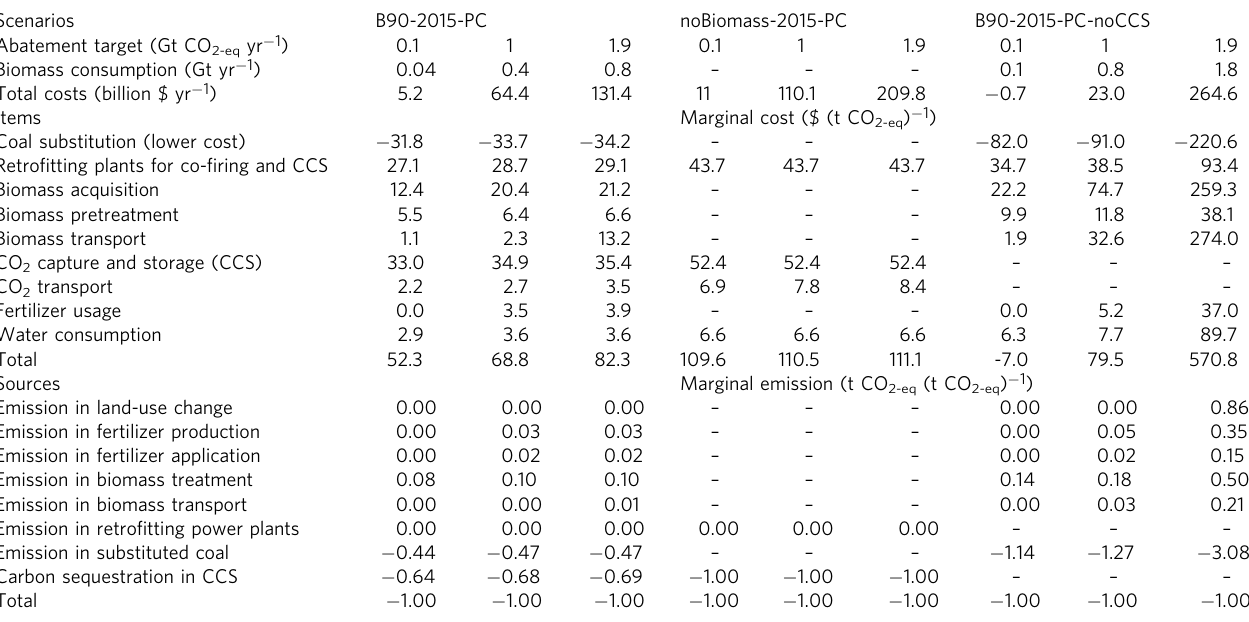
Table 1 Costs and CO 2 -equivalent emissions in the scenarios of B90-2015-PC, noBiomass-2015-PC, and B90-2015-PC-noCCS.